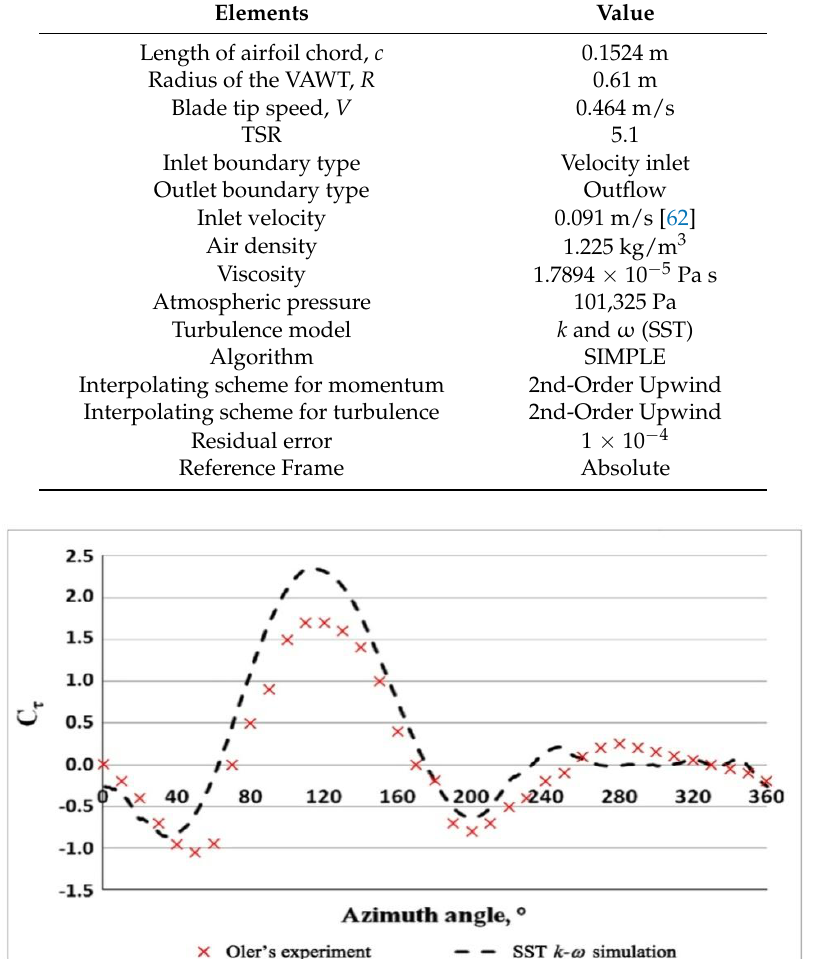
Table 2. Simulation parameters.